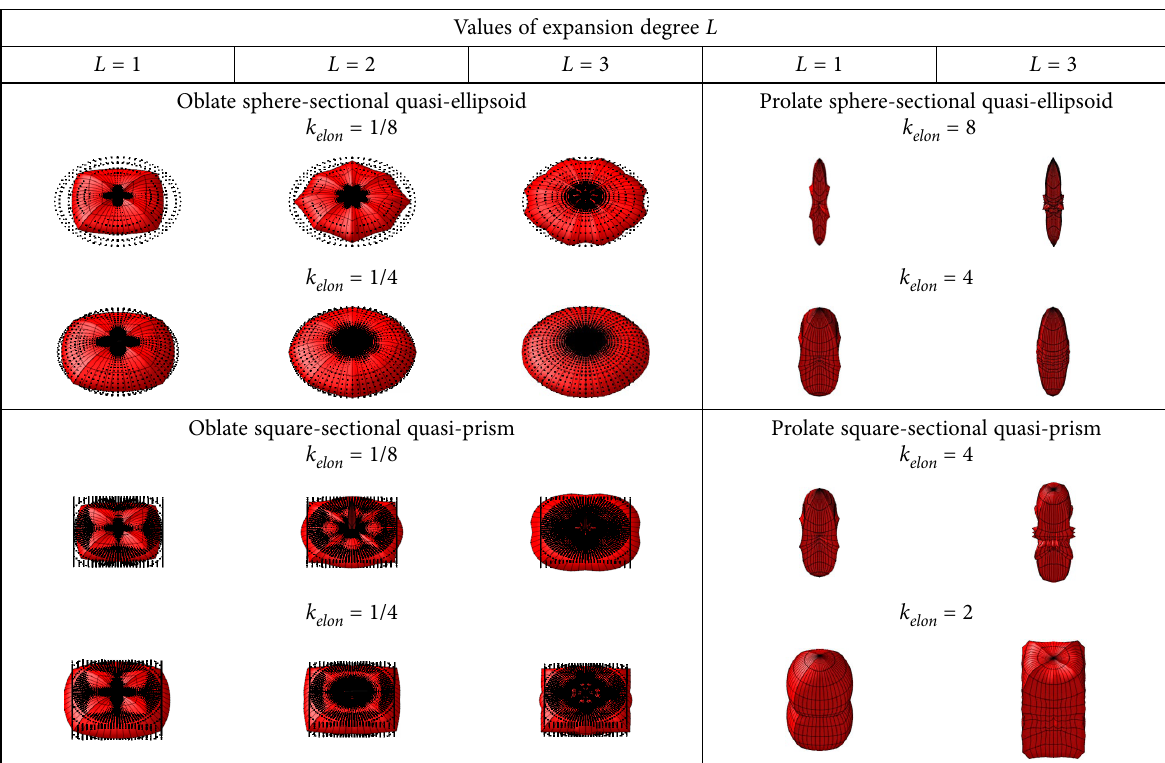
Table 1. Pictorial summary of selected